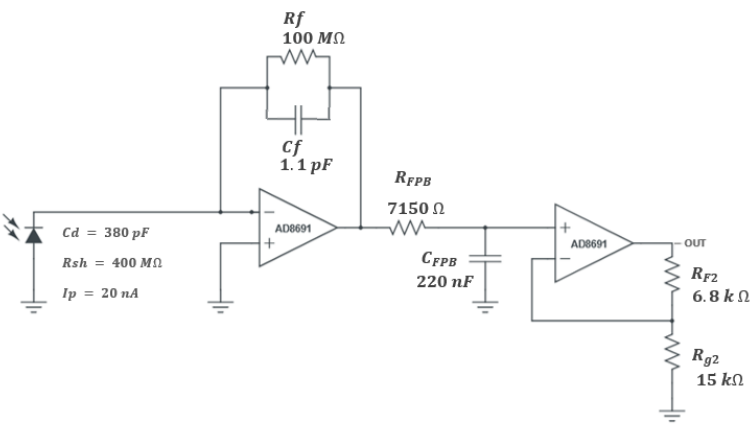
Figure 6. The signal condition circuit, composed of the transimpedance amplifier, a low-pass first order filter, and a second amplifier stage. order filter, and a second amplifier